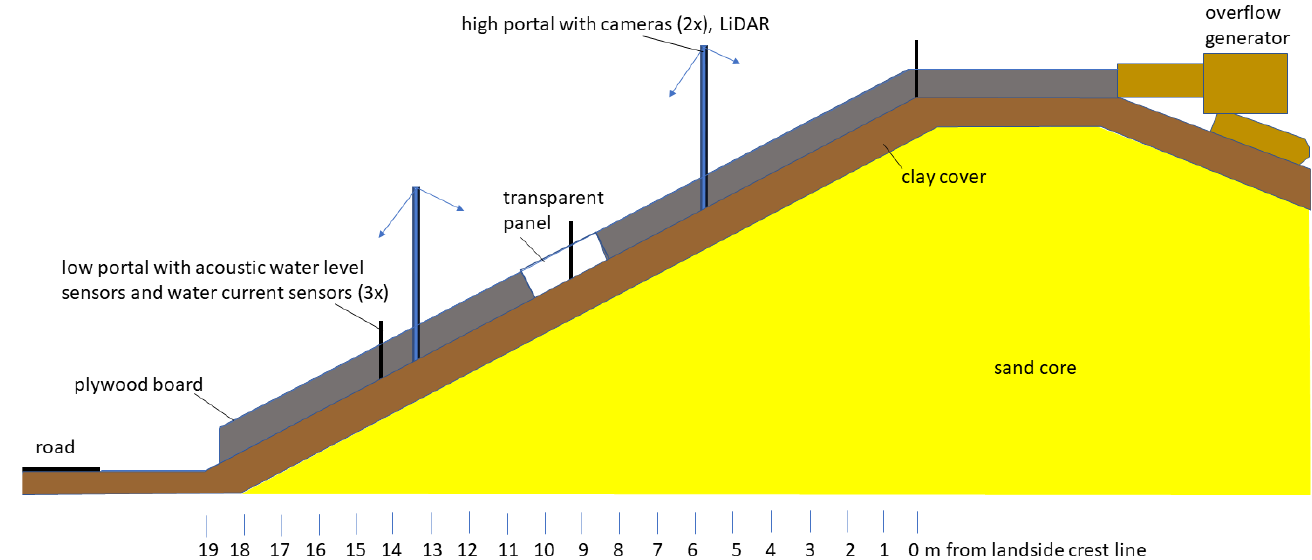
Figure 5. Schematic cross-section of a typical experiment, indicating the positions of the main instrumentation and constructions (dike dimensions and location of the road at the Dutch side).